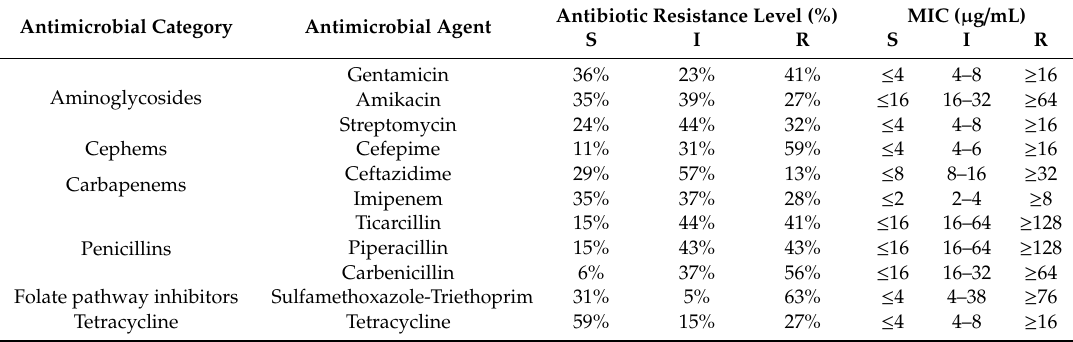
Table 1. Minimum inhibitory concentration (MIC) determination in A. baumannii clinical isolates. Antimicrobial Category